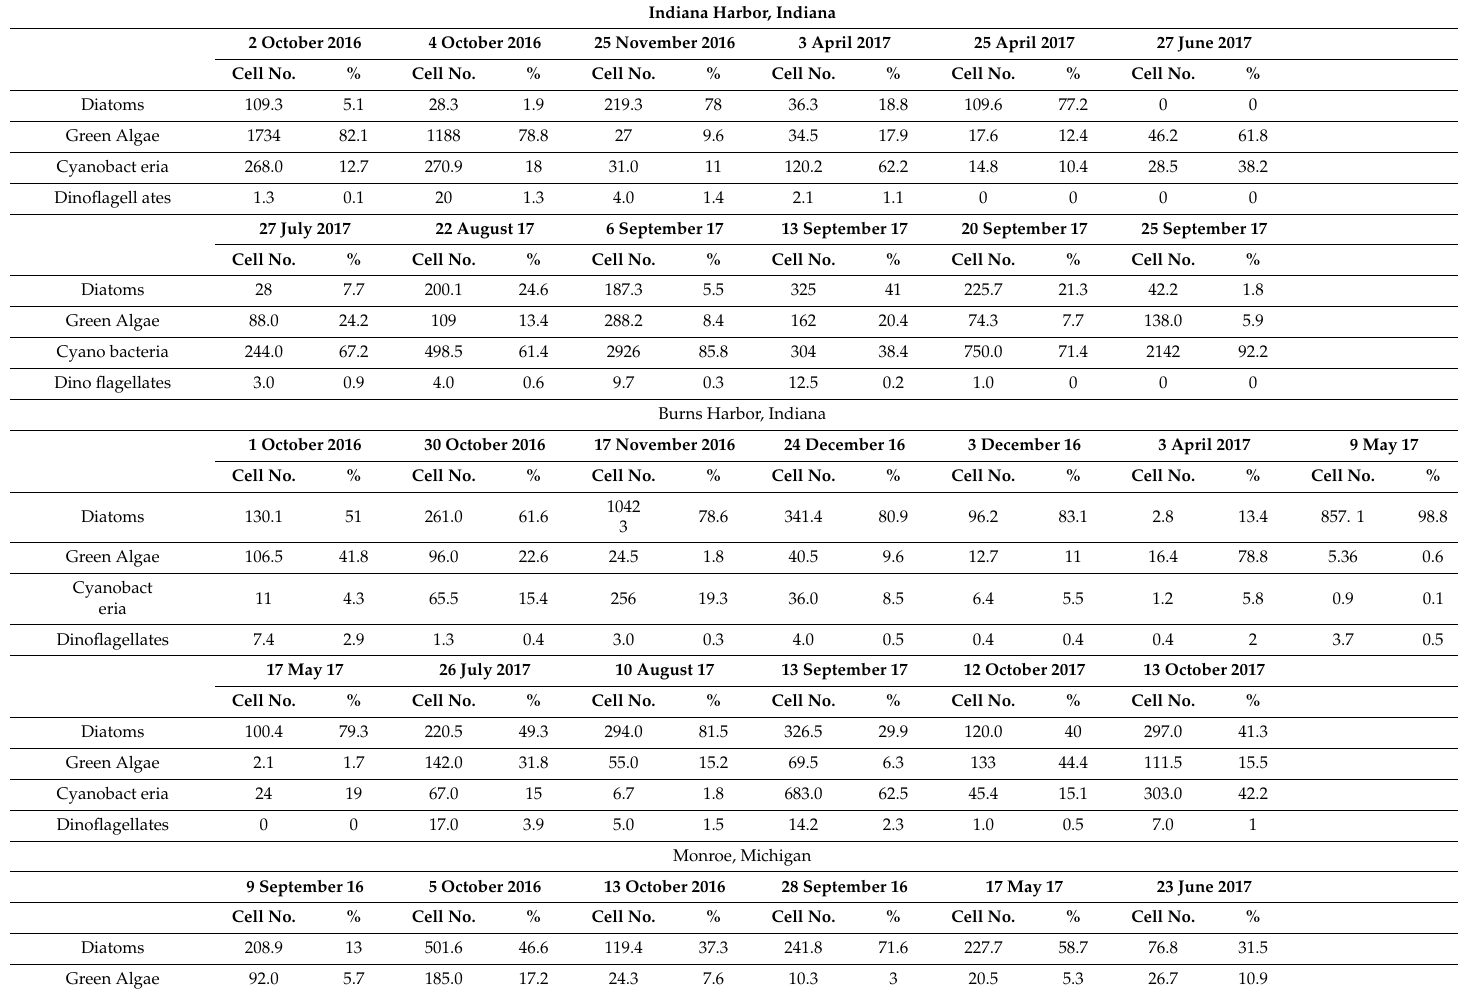
Table 3. Summary of Major Phytoplankton Taxonomic Groups as Cell Nos. per mL of sample as a percentage total phytoplankton cells per